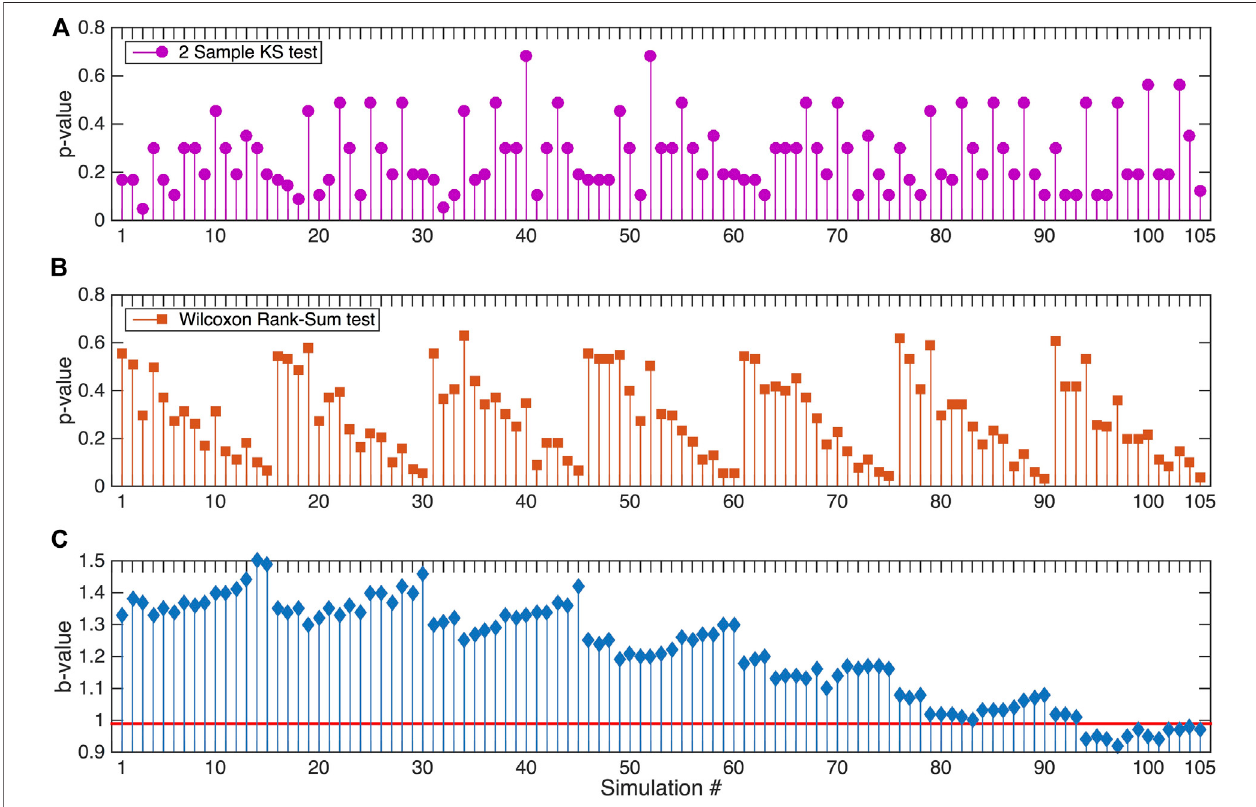
FIGURE 4 | Calculated p -values of the two Sample Kolmogorov-Smirnov (A) and the Wilcoxon Rank-Sum (B) tests for the 105 simulated catalogs at 0.05 level of signi fi cance ( α (cid:1) 0.05). The b -values (C) of each simulated catalog (blue stems) are also presented vs. the observational catalog ’ s one (solid red line).